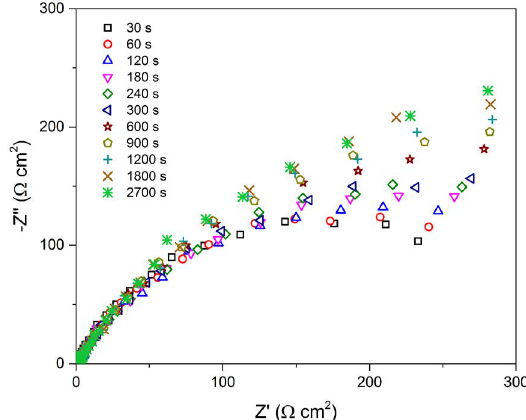
Figure 1. Nyquist plots for zirconium-treated steel samples at different immersion times, in conversion bath at pH 5.0 (sample F).